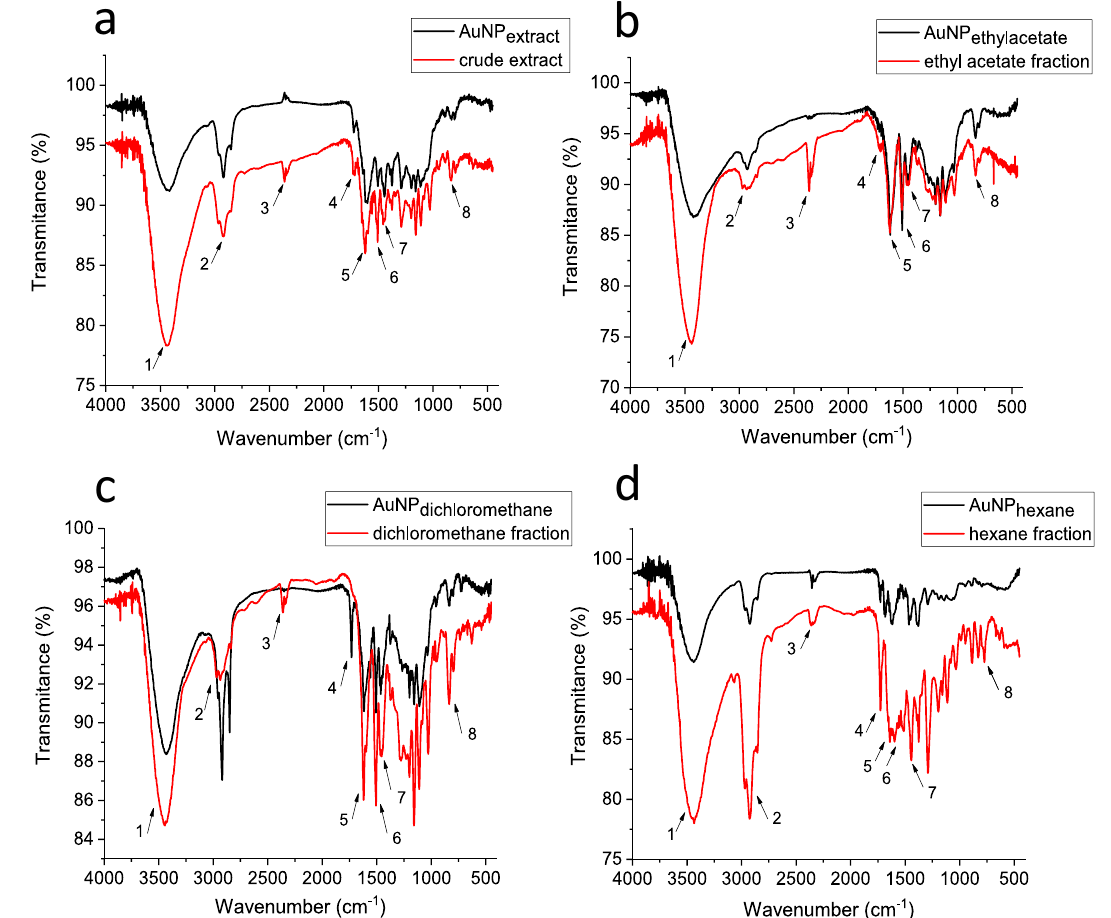
Figure 6. Fourier transform infrared (FTIR) spectra of the BRP extract (red line) and biosynthesized AuNPs (black